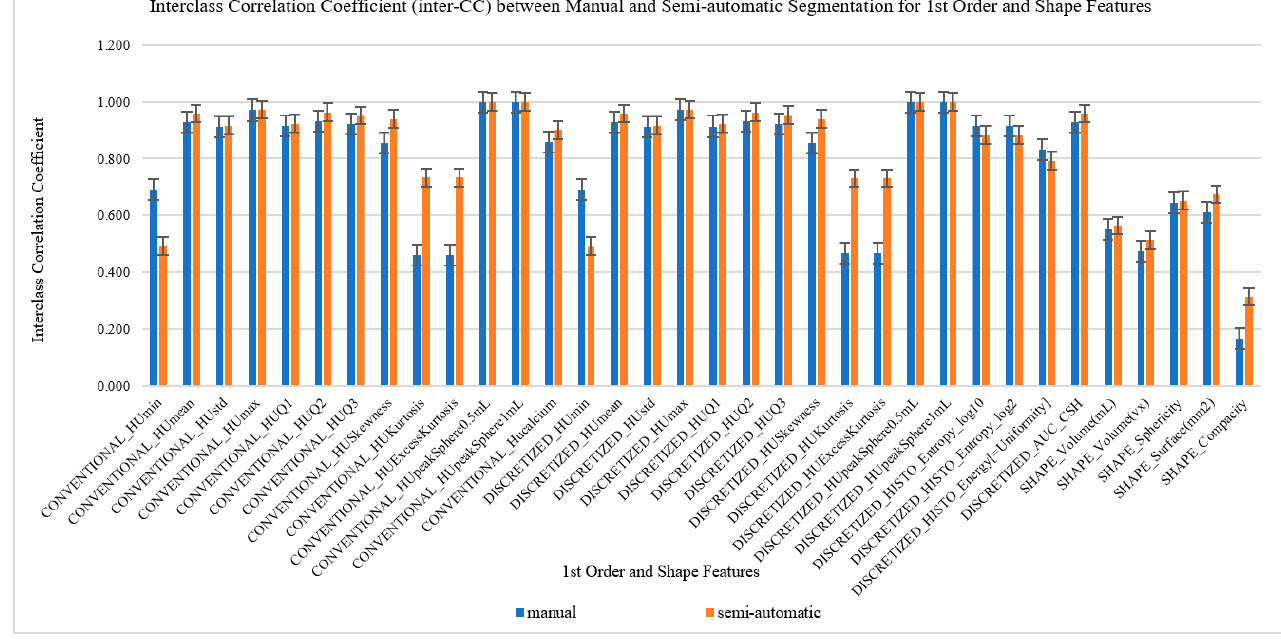
Figure 6. Interclass Correlation Coefficients (inter-CC) between manual and semi-automatic segmentation for 1st order features including the shape features to compare its reproducibility.